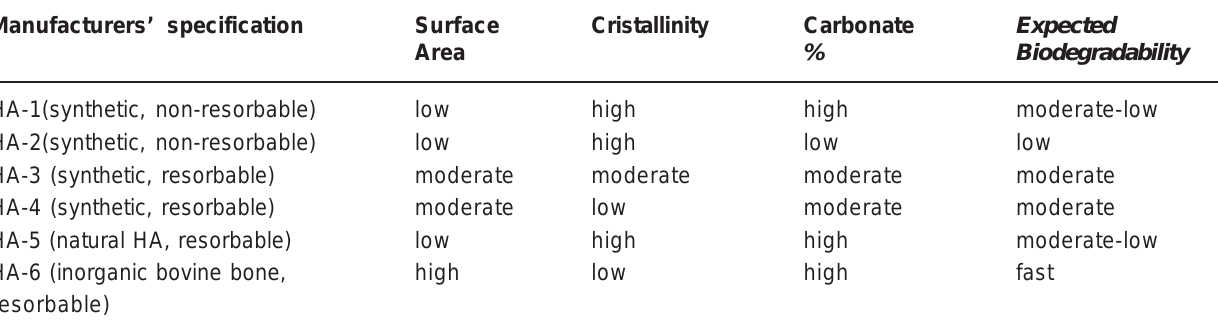
TABLE 2- Correlation between expected biodegradability and the manufacturers’ specifications